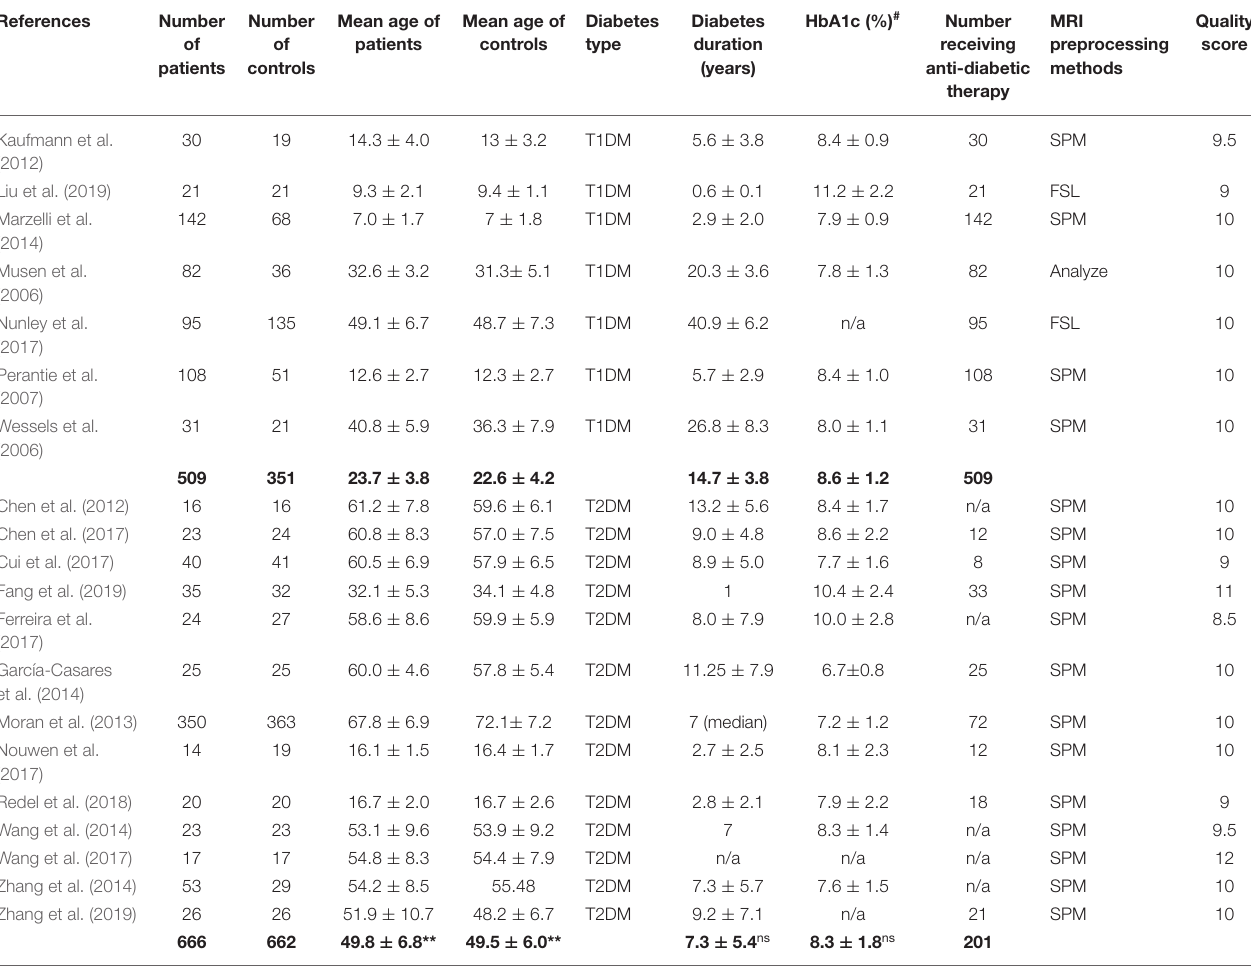
Values represent mean ± SD if not stated otherwise. Bold rows depict sum scores for number of patients, number of controls and number receiving anti-diabetic therapy, and average scores for mean age of patients and controls, diabetes